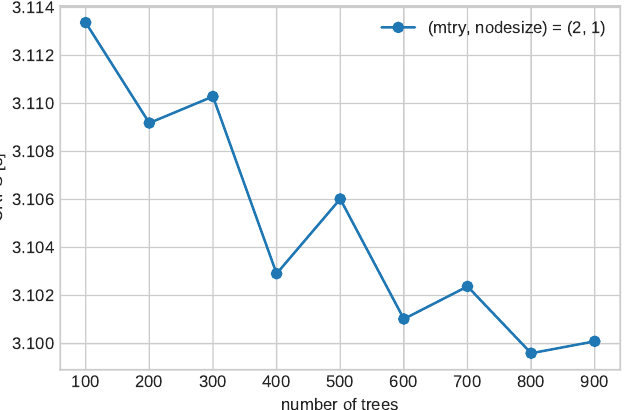
Figure 10. continuous ranked probability score based on the validation data set for different tree population sizes and a fixed setting of node-size (=1) and feature-split (=2)